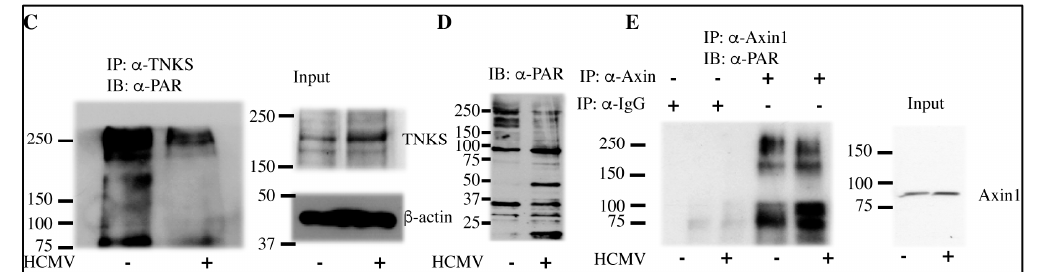
Figure 3. HCMV inactivates TNKS activity. ( A ) Western blot showing auto-PARsylation activity of immunoprecipitated TNKS at 72 hpi with HCMV Towne at MOI = 3. Immunoprecipitated TNKS was used for the PARsylation assay as described in Materials and Methods. XAV939 was included as a positive control for TNKS inhibition; ( B ) Proteasomal degradation assay from lysates assayed in ( A ) to indicate lysate quality and activity; ( C ) Western blot showing detection of PAR residues on TNKS immunoprecipitated from non-infected and HCMV-infected HFFs (MOI = 3 at 72 hpi); ( D ) Detection of PAR residues by Western blot in non-infected and HCMV Towne-infected HFF (MOI = 3, 72 hpi) cell lysates to show no loss of PARsylation activity from other PARPs in general; ( E ) Western blot showing detection of PAR residues on Axin1 immunoprecipitated from non-infected and HFFs infected by HCMV Towne at MOI = 3 at 72 hpi.